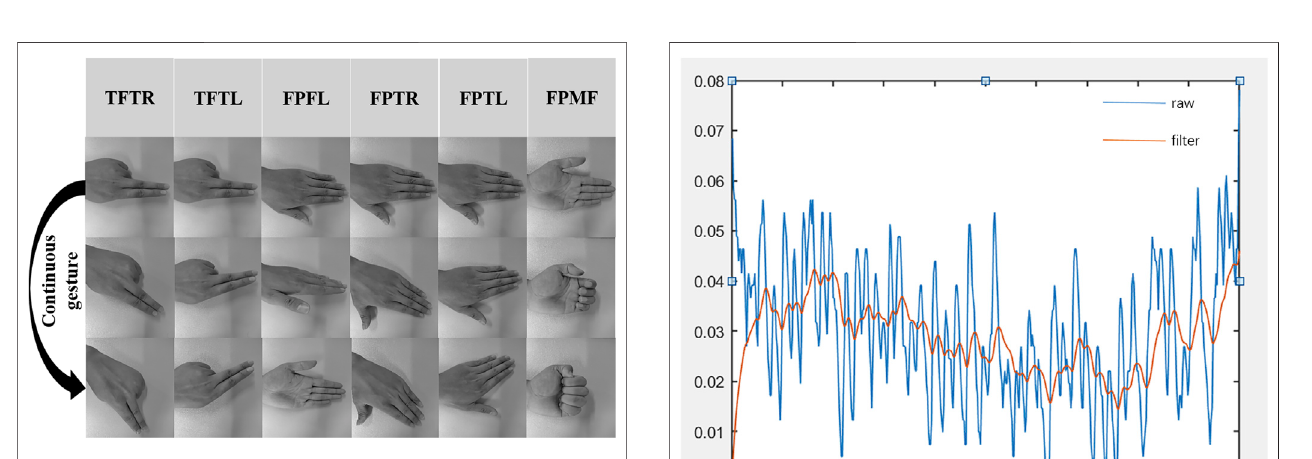
FIGURE 8 | Six dynamic hand movements.